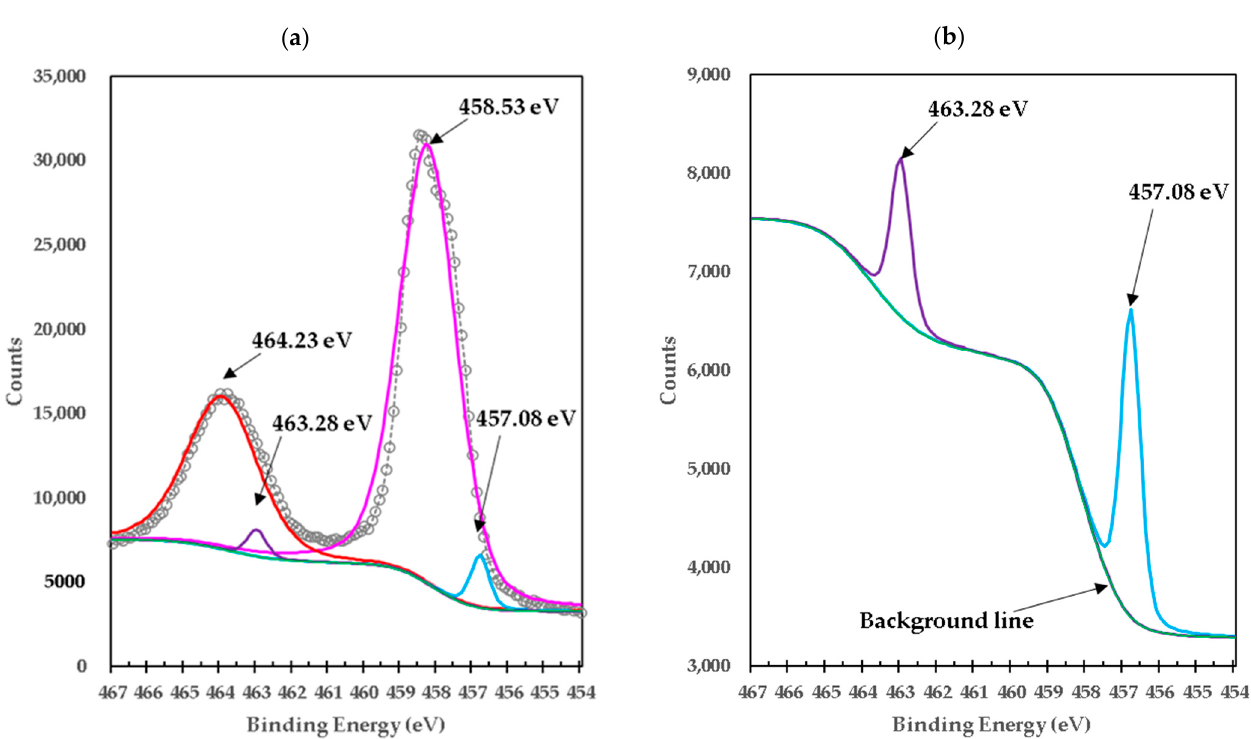
Figure 4. ( a ) High-resolution XPS spectra of Ti2p in high-purity titania; ( b ) details for sample M3.